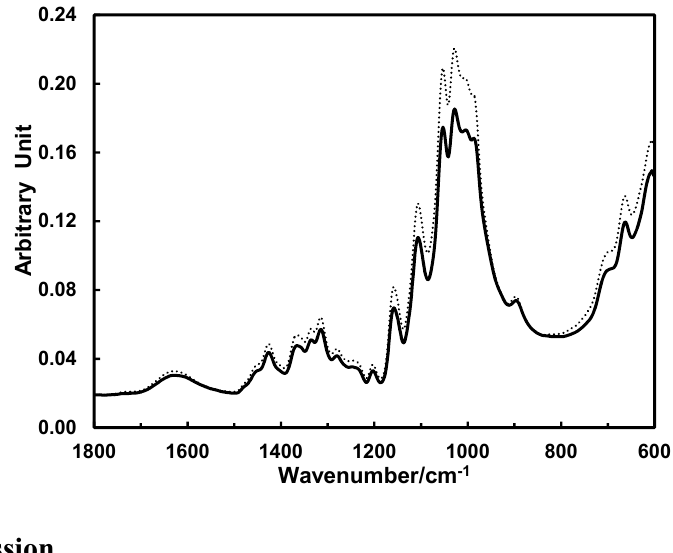
Figure 2. Representative attenuated total reflection-sampling device based Fourier transform infrared (ATR-FTIR) spectra of cotton fibers with CI line) and 90% (solid